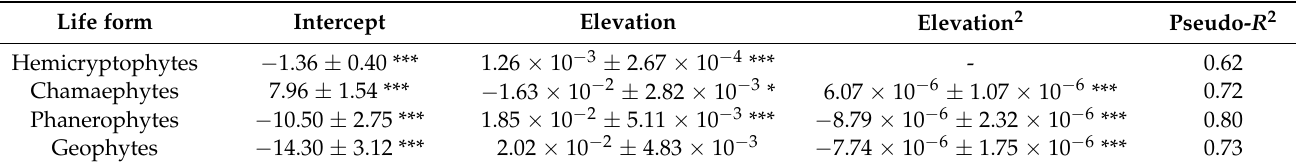
Table 2. Summary statistics of fitted polynomial generalized linear models for proportion of plant chorotypes along an elevational gradient on a Central Apennine mountain (Mount Genzana). Error refers to Standard Errors. Model goodness-of-fit is expressed as McFadden’s psedudo-R2. * = p < 0.05; *** p < 0.0001. Life